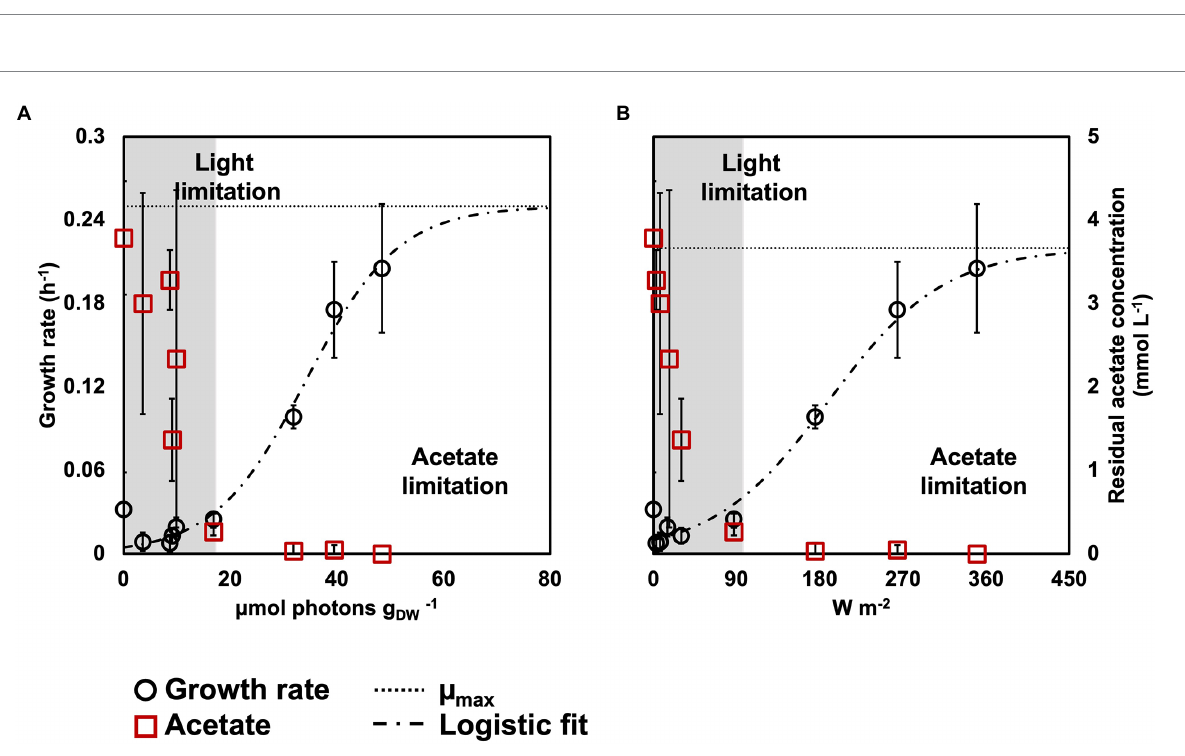
FIGURE 2 Biomass growth rates (black circles) and acetate concentration (red squares) in relation to rEX (A) and incident light intensity (B) . The growth rates fitted a logistic regression (dashed line), that allowed to identify the μ max for the PPB enrichments (dotted line). Based on the acetate concentration at the end of the reaction phase, an acetate- and a light-limited condition were